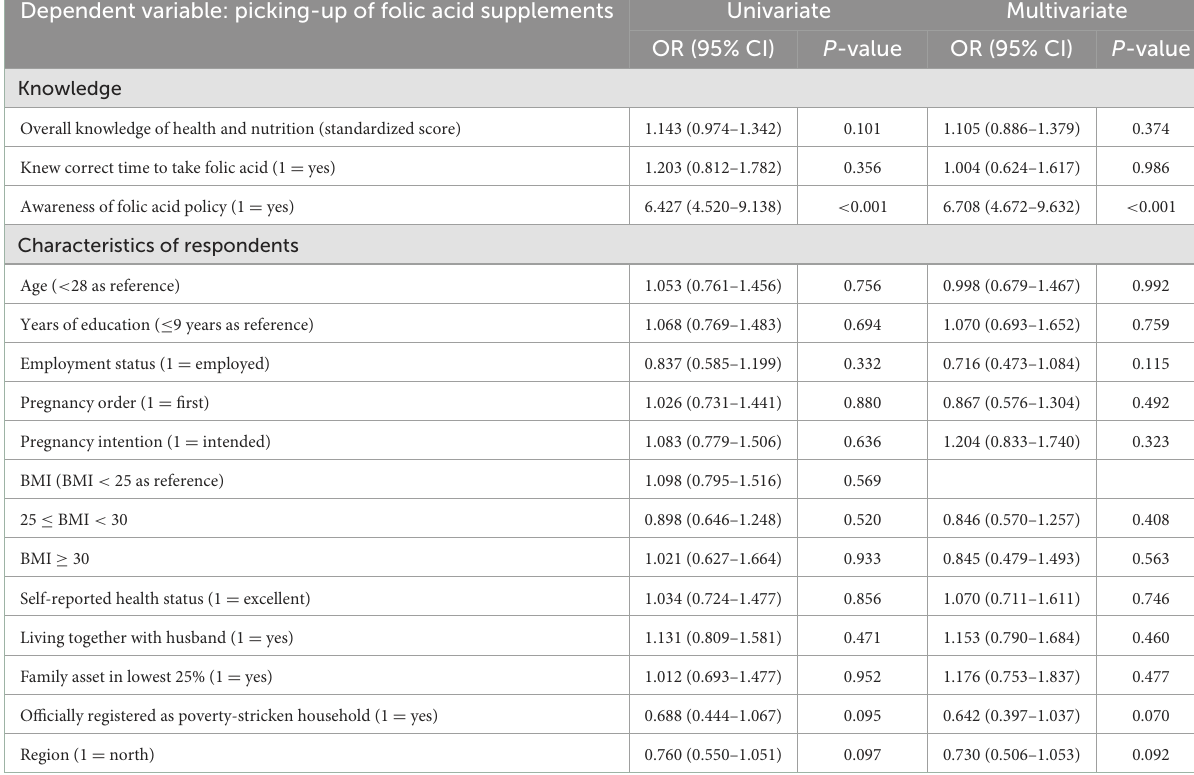
TABLE 3 Results of univariate and multivariate logistic regression analyses of variables related to the picking up of folic acid supplements. Dependent variable: picking-up of folic acid